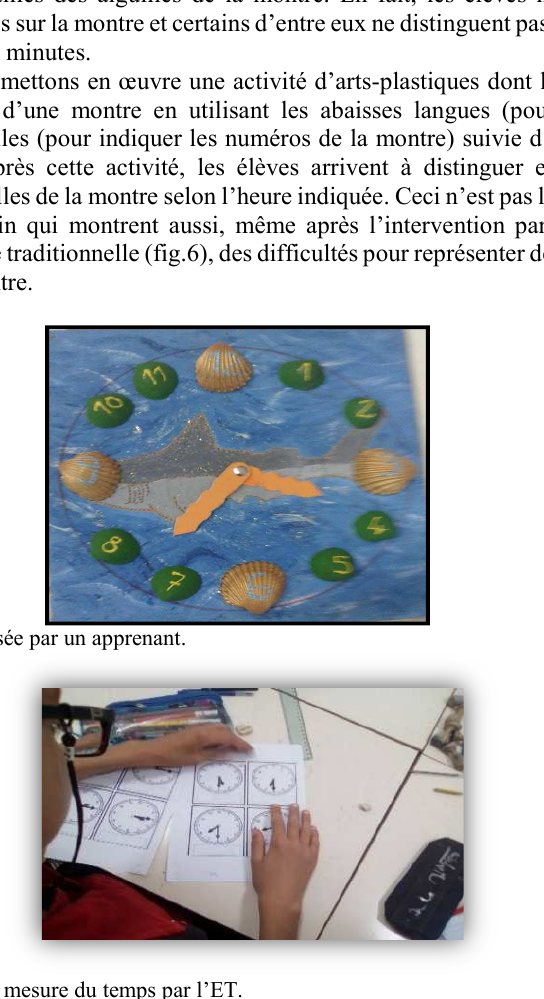
Fig. 6. Apprentissage de mesure du temps par